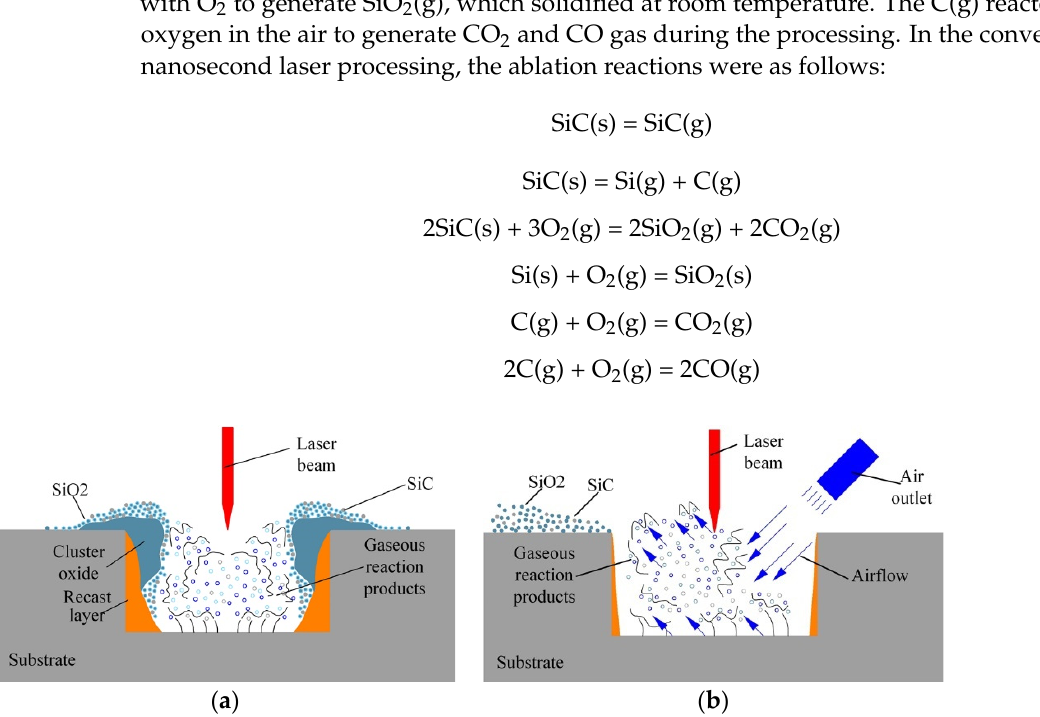
Figure 11. Schematic of material removal in the fiber nanosecond laser processing of SiC material: ( a ) conventional laser processing, ( b ) blowing-assisted laser processing.